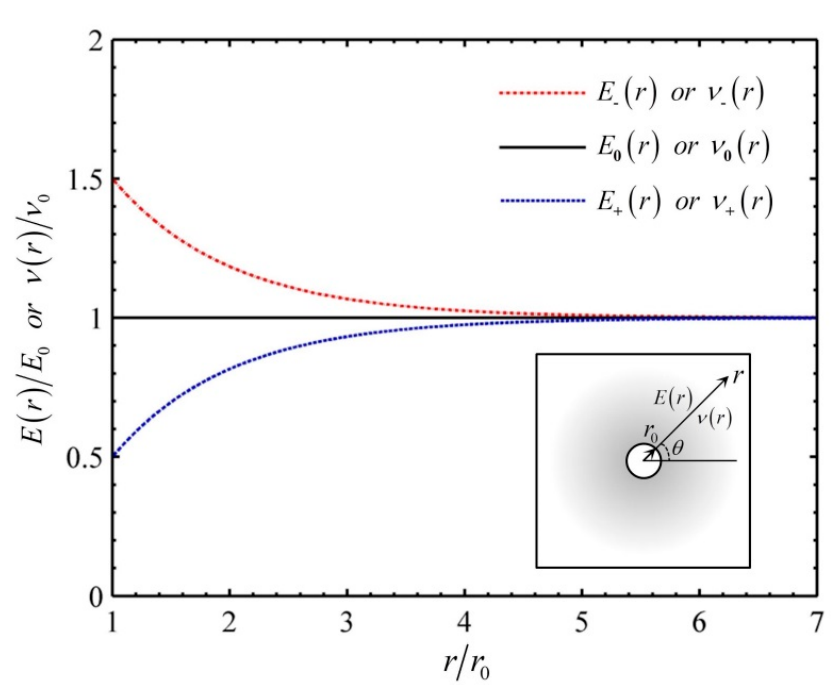
Figure 2. Variation of Young’s modulus and Poisson’s ratio along the radial direction.